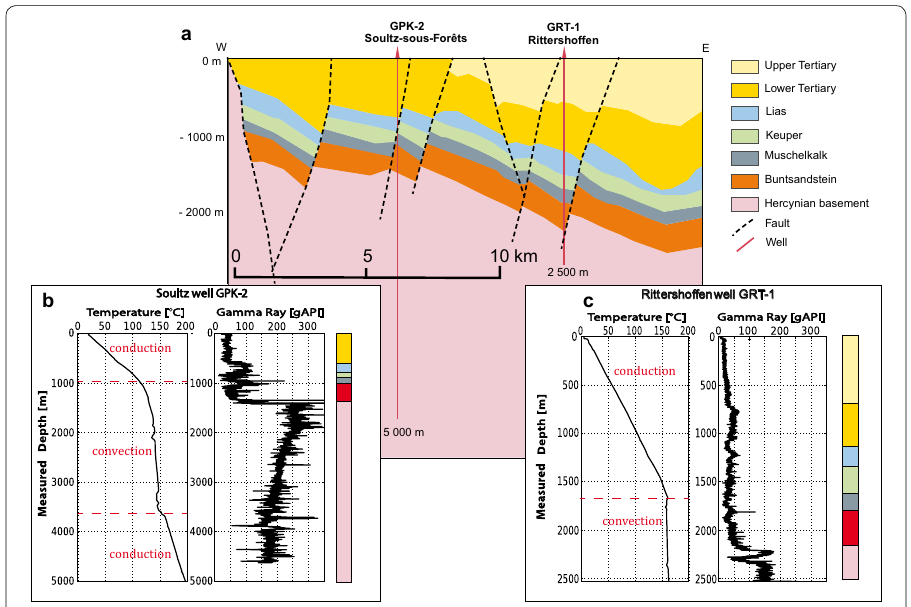
Fig. 3 a East–west schematic section of the Rhinegraben crossing the Soultz-sous-Forêts and the Rittershoffen wells. Gamma ray and temperature log at equilibrated thermal conditions between surface and 5 km depth, b in the Soultz-sous-Forêts well, and c in the Rittershoffen